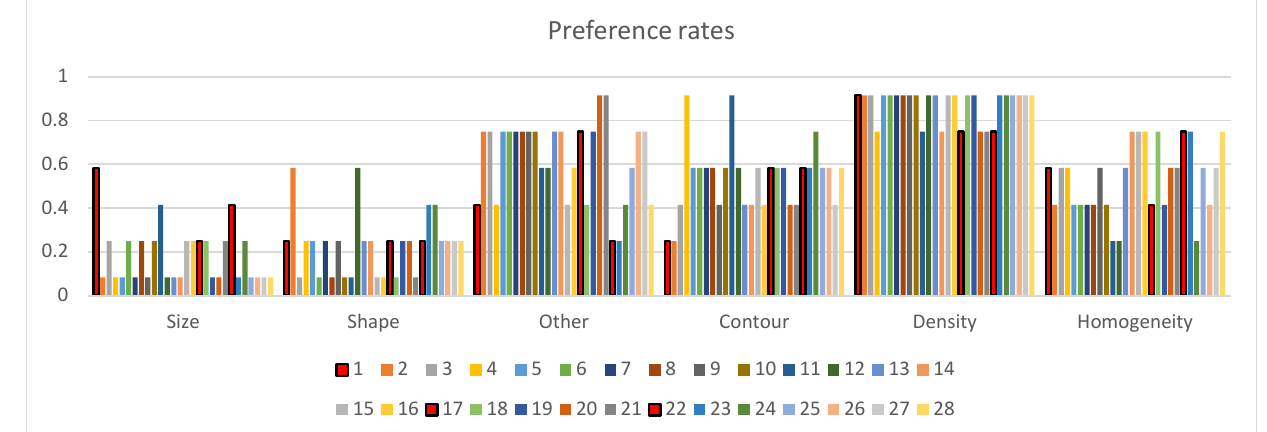
Figure 4. The preference rates for the 28 experts and 6 attributes. In the upper subplot the different experts are denoted by numbers 1 to 28 on the horizontal axis, the attributes by the color of the columns according to the legend at the bottom of the plot. The lower subplot contains the same information, but sorted according to the attributes. The inconsistent experts 1, 17, and 22 are denoted by a red column with black borderlines, the others have different colors in the lower subplot.